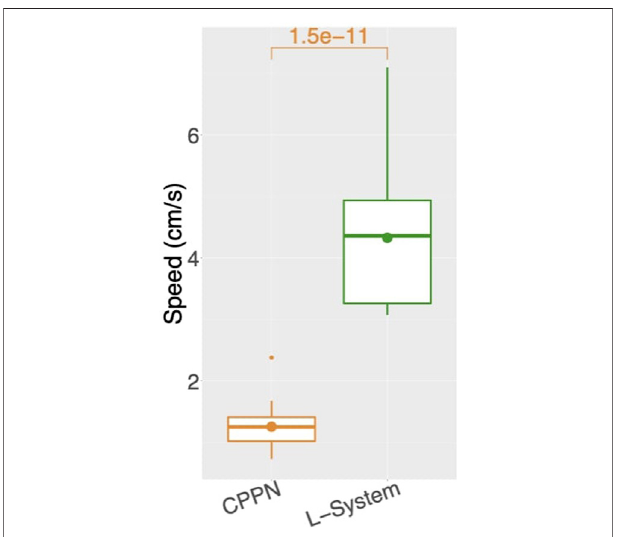
FIGURE7| Averagespeedamongruns:foreachrun,includesallrobots of the fi nal generation (149) aggregated using the median. Number above box is the p value of a Wilcoxon test.